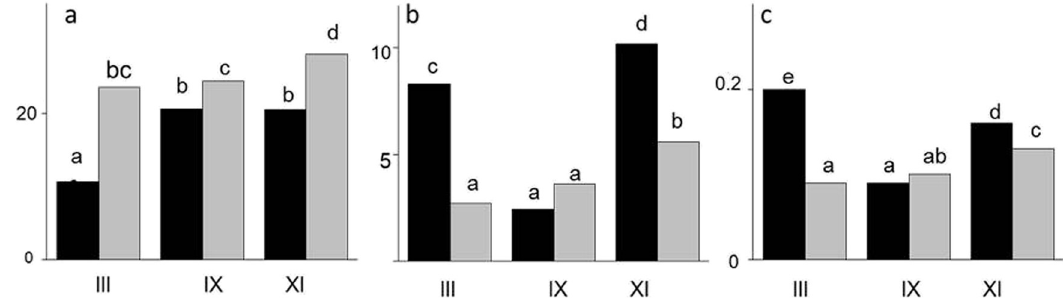
Figure 2: ( a ) Firmness ( N ) ; ( b ) adhesiveness ( N × s ) ; ( c ) cohesiveness ( dimensionless ) of dough prepared with formulations III, IX, or XI with sugar ( black column ) or with sugar and algarrobo fl our ( grey column )